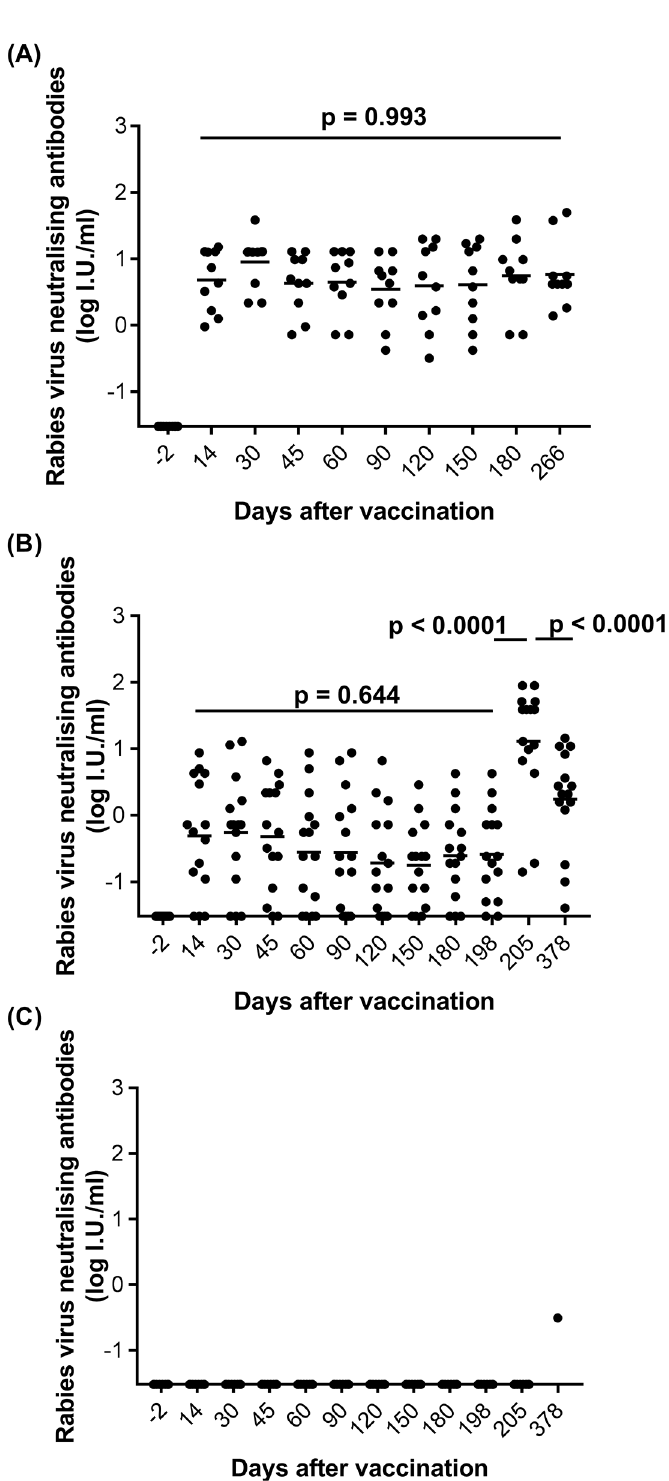
Fig 1. Aggregate data of rabies VNA titres (log IU/ml) for each group at each time point. RabiesVNA titres of each animalin Group 1 (A) , Group 2 (B) , and Group 3 (C) were respectivelydisplayed, and the geometric means at each time point were indicatedwith the line in each group. The X-axis stands for the time point (days after vaccination) that animals were bleed for the FAVN test. The solid circle icons are the VNA titre value from each animal in each group at each time point (the digital data for individualanimalsrefers